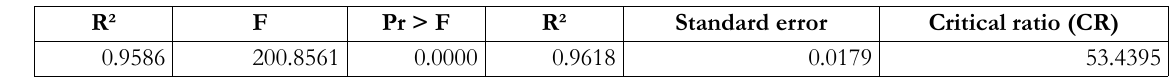
Table 5. Coefficient Determination (R 2 ) of Model